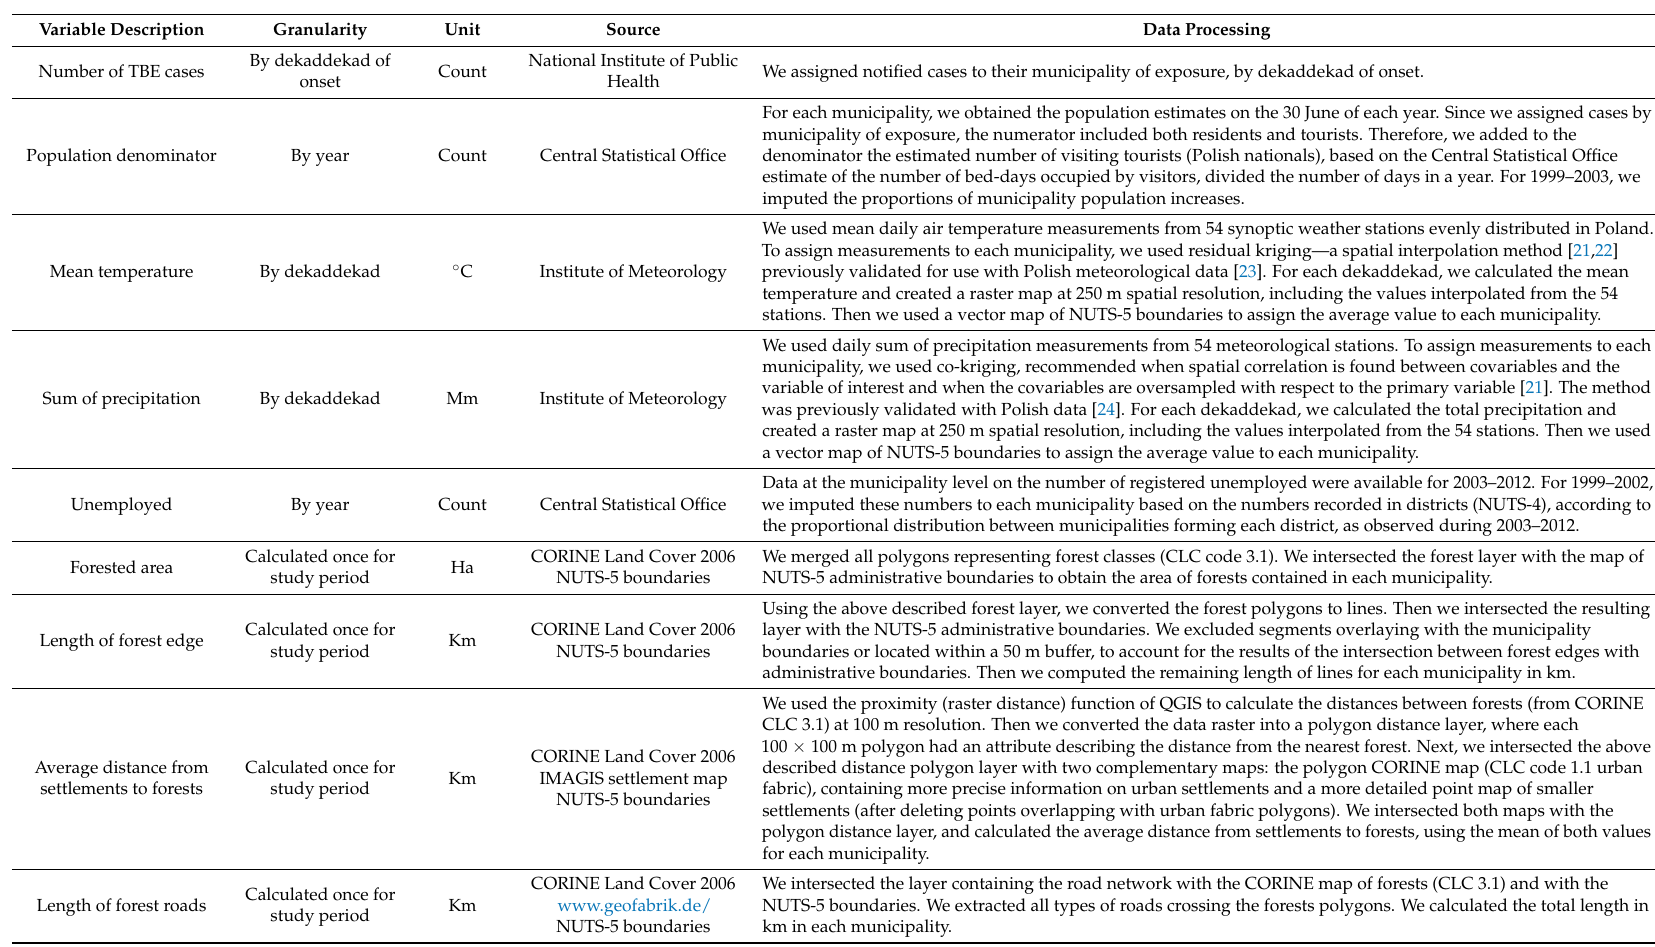
Table 1. Characterisation of variables preparation for the predictive model, Poland,